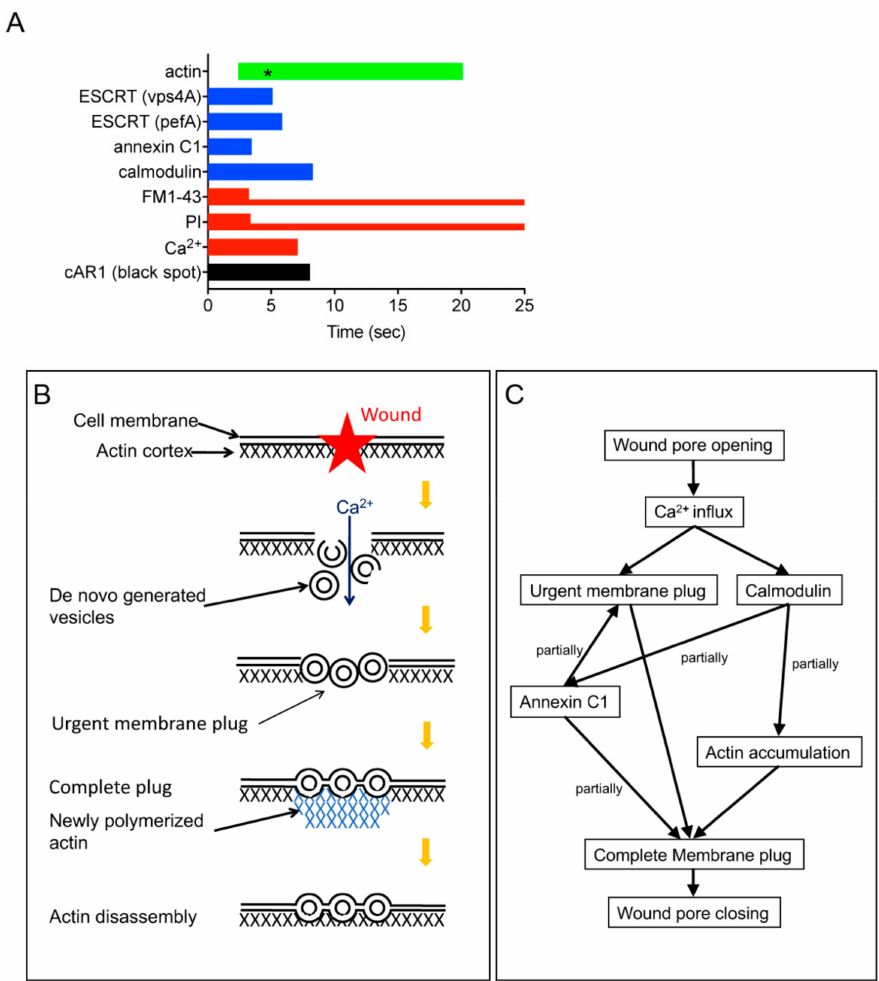
Figure 5. A summary of wound repair in Dictyostelium cells. ( A ) A summary of the duration time of each probe. Aster (black) in the actin bar (green) indicates the peak of actin accumulation. FM1-43 and PI accumulate at the wound site for 2–3 sec, but their fluorescence remained as a membrane plug during observation. ( B ) A schema for a wound repair mechanism. Upon wounding, Ca 2 + enters through the wound pore and trigger the de novo generation of vesicles and mutual fusion of vesicle–vesicle and vesicle–cell membrane to make an urgent membrane plug. Actin accumulates to complete the plug, depending on Ca 2 + and calmodulin. ( C ) A signal pathway for the wound repair, estimated from the present